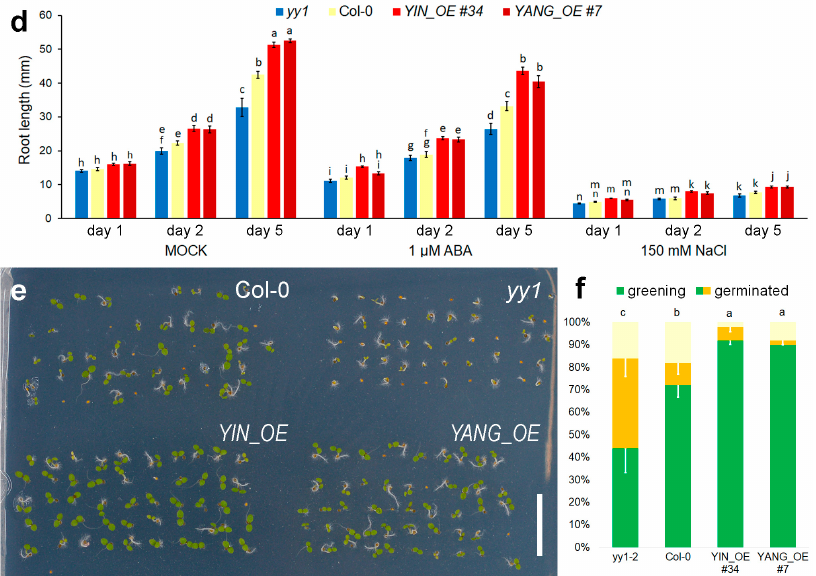
Figure 8. Expression of YIN and YANG promotes root growth and accelerates seed germination in Arabidopsis. ( a – d ) Root growth among yy1 , Col-0, and transgenic YIN_OE ( #34 ) and YANG ( #7 ) plants. Three-day-old seedlings grown on MS medium were transferred to MS medium containing 0 ( a , Mock), 1 μ M ABA ( b ), or 150 mM NaCl ( c ), and grown vertically for 5 days. Scale bars = 10 mm. ( d ) Root length in mm; N ≥ 6 plates with approximately 5–10 plants of each genotype. ( e , f ) Seed germination and cotyledon greening ratios of Col-0, yy1 , and YIN_OE ( #34 ) and YANG ( #7 ) transgenic plants (N = 50). Seeds geminated on MS medium for 4 days. ( d , f ) Error bars represent the standard error of the mean; statistical significance ( p ≤ 0.05) was determined by Student t -test and a-n mark groups of significant